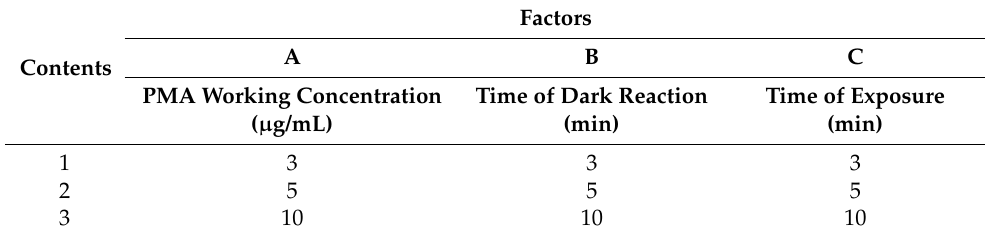
Table 1. PMA pretreatment conditions of the orthogonal